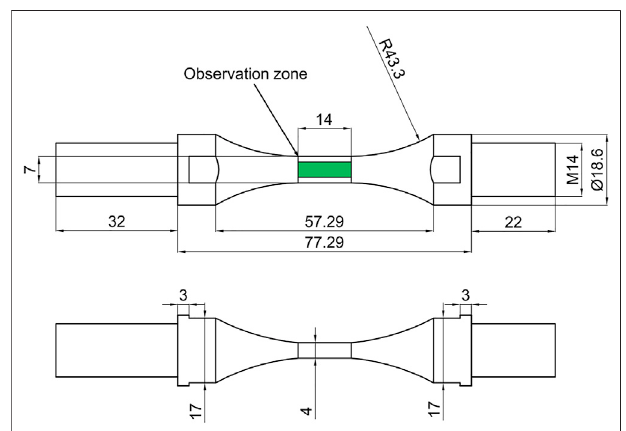
FIGURE 1 | Dimension diagram of the corrosion fatigue testing specimen (Unit: